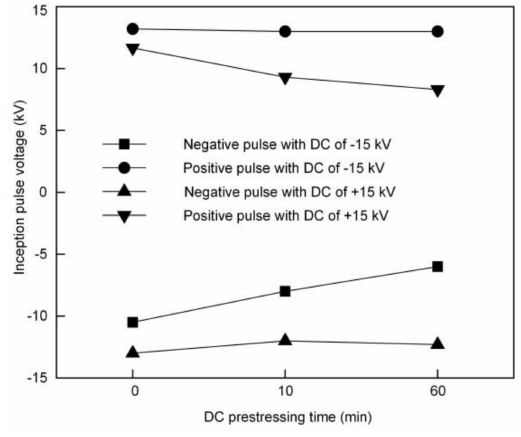
Figure 5. Inception pulse voltage with different DC prestressing times.